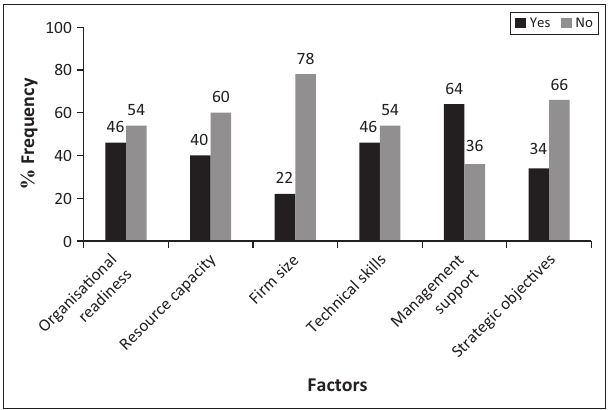
FIGURE 7: Frequency of organisational factors.